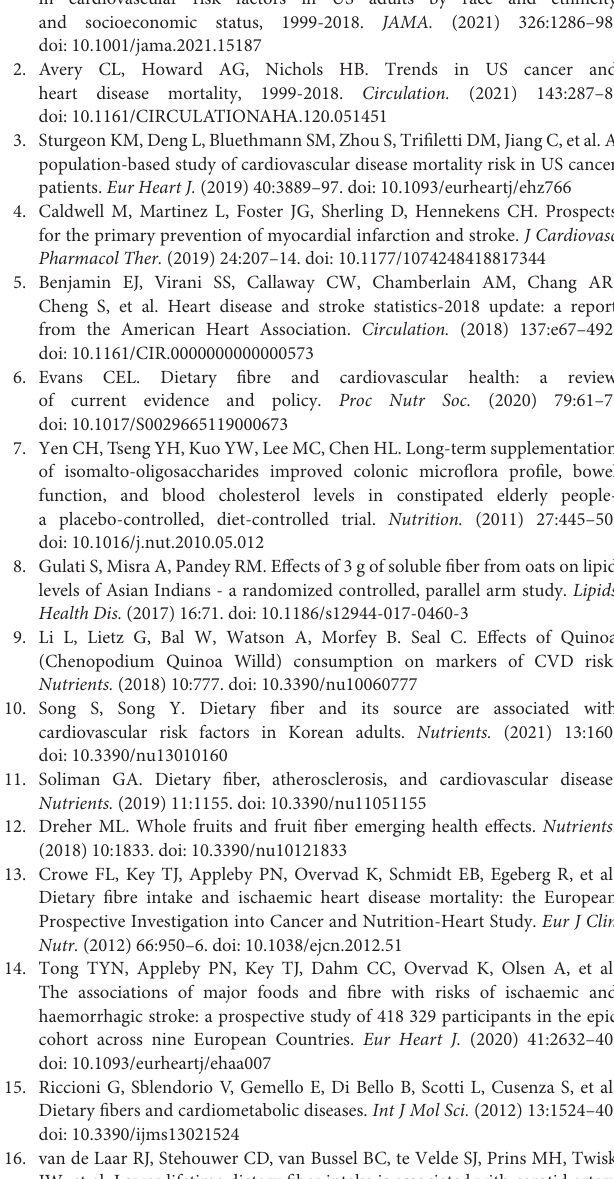
Supplementary Figure S2 | Association between dietary fiber intake ( ± 3 SD above the mean excluded) and odds of nonfatal cardiovascular event (stroke and MI) using the generalized additive model. Adjusting for potential confounding variables (age; sex; race; marital status; educational level; PIR; BMI; smoking status; systolic blood pressure; diastolic blood pressure; glucose, cholesterol, triglyceride, HDL, and glycohemoglobin levels; energy intake; vigorous activity; diabetes; hypertension; hypercholesterolemia; sleeping disorder; and hypoglycemic, antihypertensive, lipid-lowing, and aspirin drugs). The red points line represents the fitting spline. The blue points line represents the 95% confidence intervals. MI, myocardial